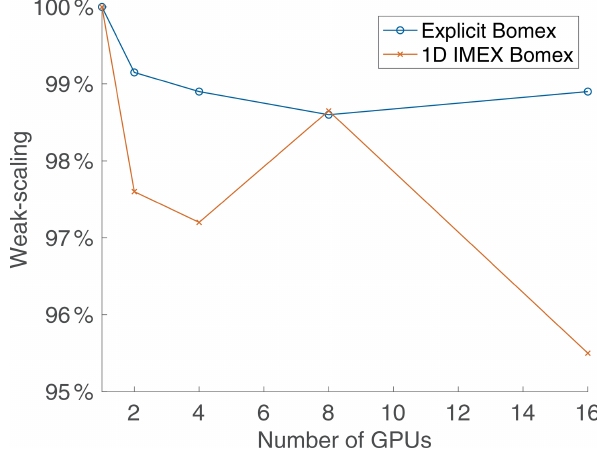
Figure 16. BOMEX weak scaling using 1D IMEX versus fully ex- plicit time